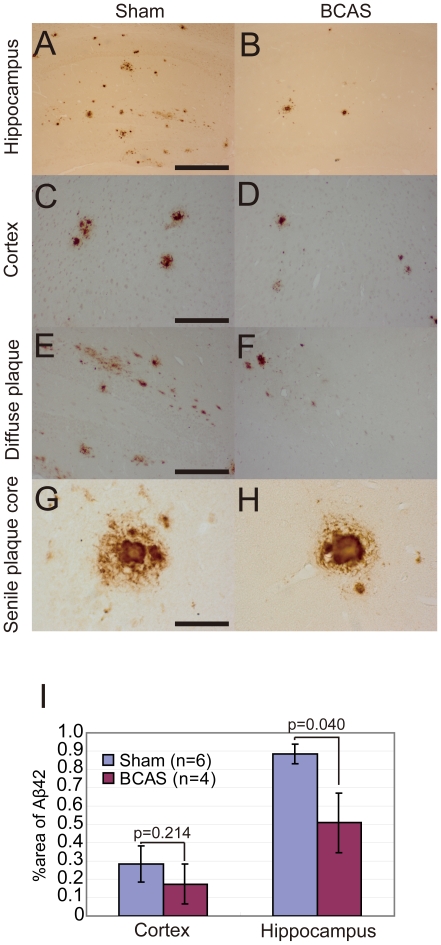
Chronic cerebral hypoperfusion reduced the Aβ1-42 stained area in the APPSw/Ind-Tg mice.Immunohistochemistry for Aβ1-42 showed intense staining in the hippocampus (A, B, E, F) and in the cerebral cortex (C, D) of the APPSw/Ind-Tg/sham mice (n = 4; A, C, E, G) and APPSw/Ind-Tg/BCAS mice (n = 6; B, D, F, H). (I) The area positive for Aβ1-42 was analysed in the cortex and the hippocampus. Scale bars: 400 µm (A, B), 300 µm (C–F), 80 µm (G, H).